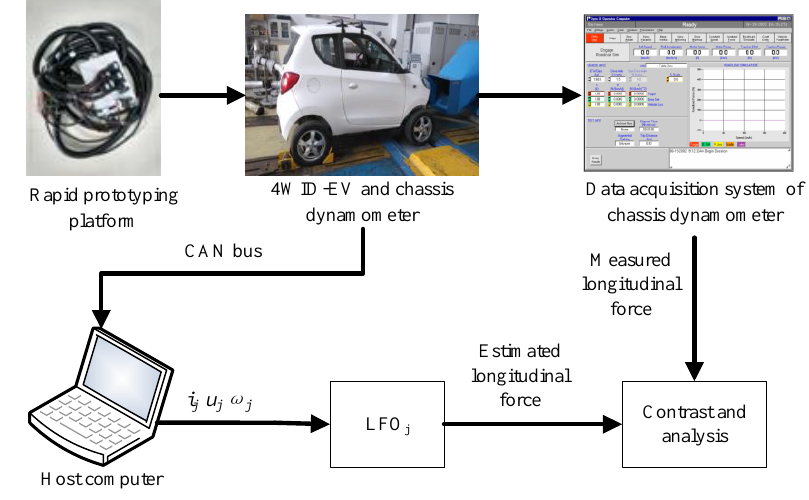
Figure 19. Vehicle test on chassis dynamometer bench.